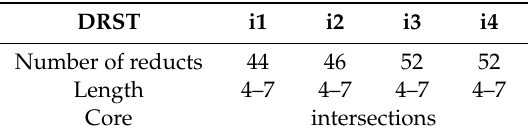
Table 6. Number, size, and cores of reducts designated using the DRST method for the selection of road sections to the scale of 1:50,000.